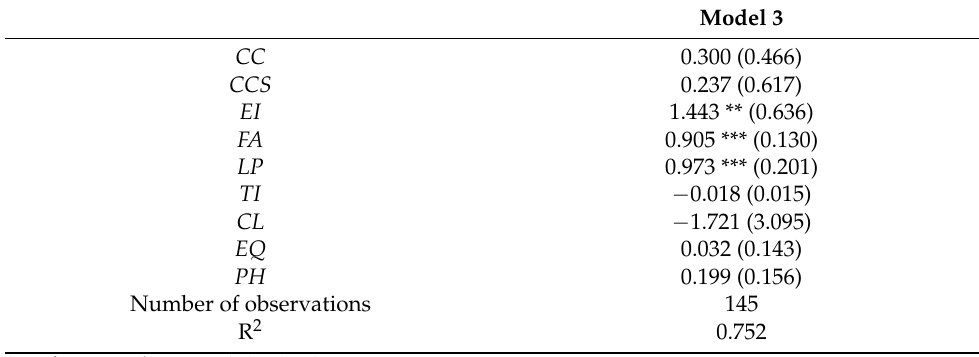
Table 5. Regression results of Model